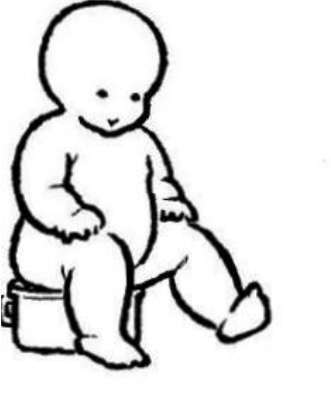
Figure 19. “Go Slow on Toilet Training”.